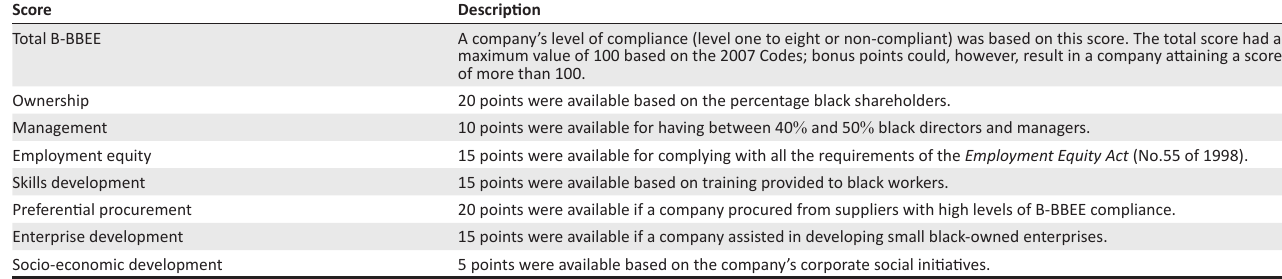
TABLE 5: Description of the Broad-Based Black Economic Empowerment scores.